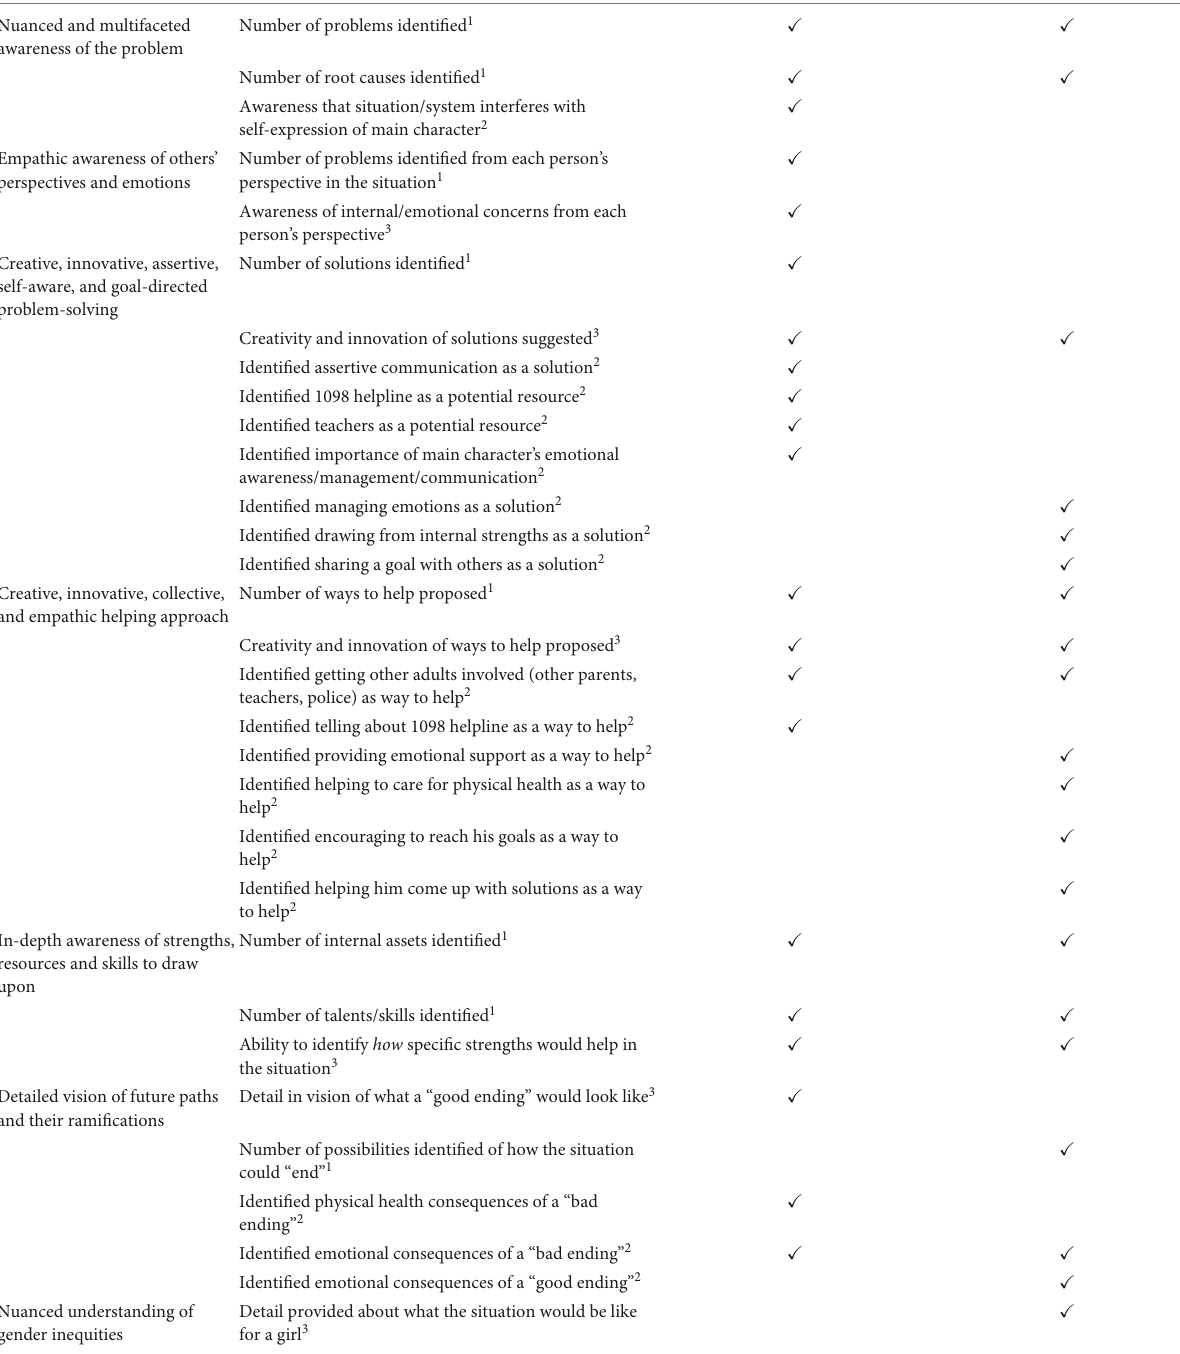
TABLE 6 Outcomes in which intervention arms were observed to fare better than control arm. Higher-order constructs Outcomes sought by